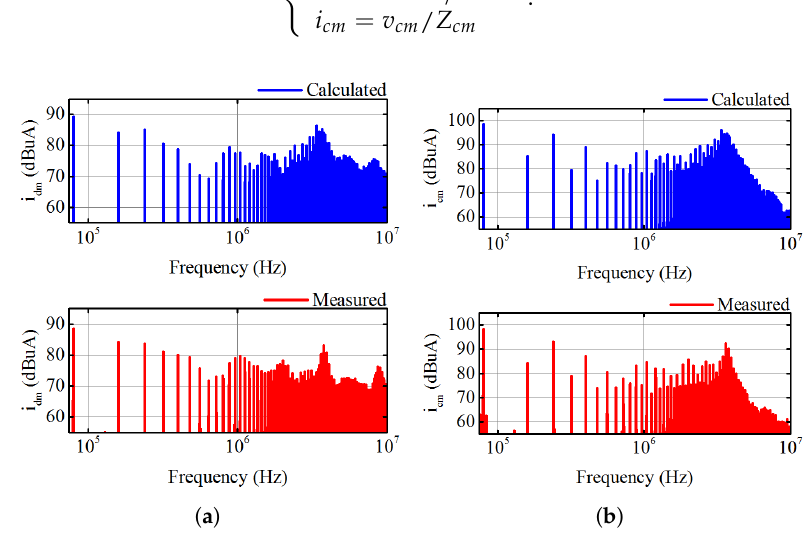
Figure 13. Calculated and measured spectra of i dm and i cm : ( a ) i dm , ( b ) i cm